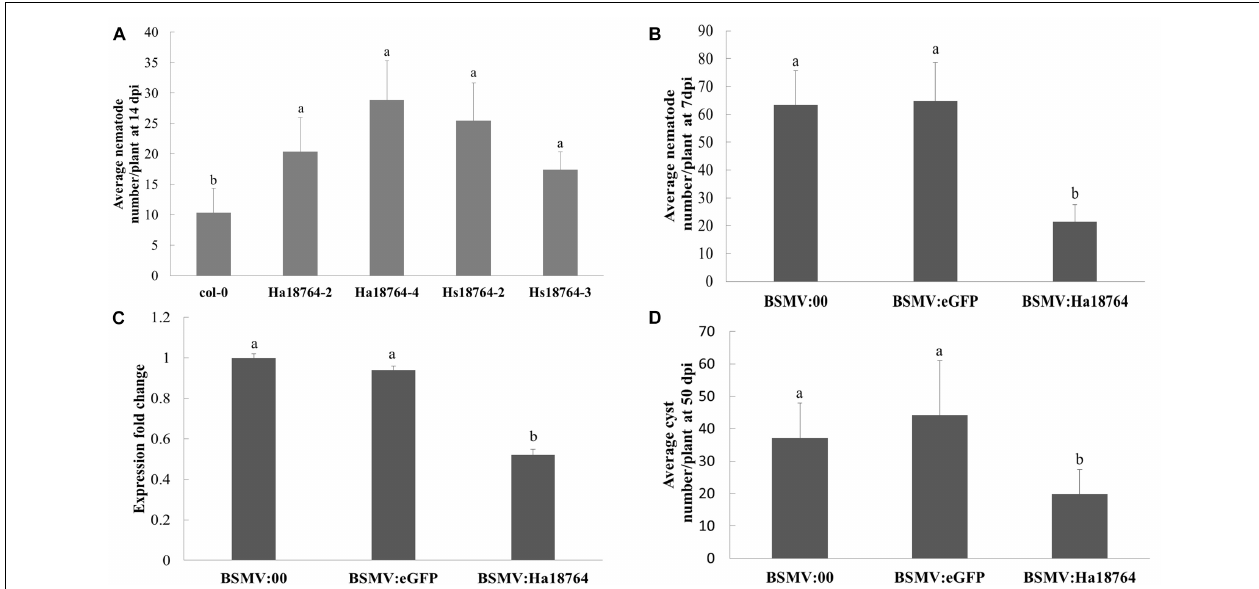
FIGURE 5 | Effects of overexpression and host-derived RNAi of Ha18764 on plant susceptibility to nematodes. (A) Arabidopsis Ha18764 or Hs18764 expression homozygous T3 lines increased the number of infected H. schachtii in roots compared to wild-type (WT) lines. (B) Relative expression level of Ha18764 in H. avenae individuals collected on wheat inoculated by BSMV:18764 and BSMV:00 at 7 dpi (days post-infection). (C) Number of juveniles/plant in wheat roots at 7 dpi. (D) Number of females/plant at 50 dpi in wheat roots. Shown are means ± SD from n = 5–10 plants. The independent experiments were repeated thrice, with consistent results. Columns for the same time point or treatment marked with different letters are significantly different ( P < 0.05) from each